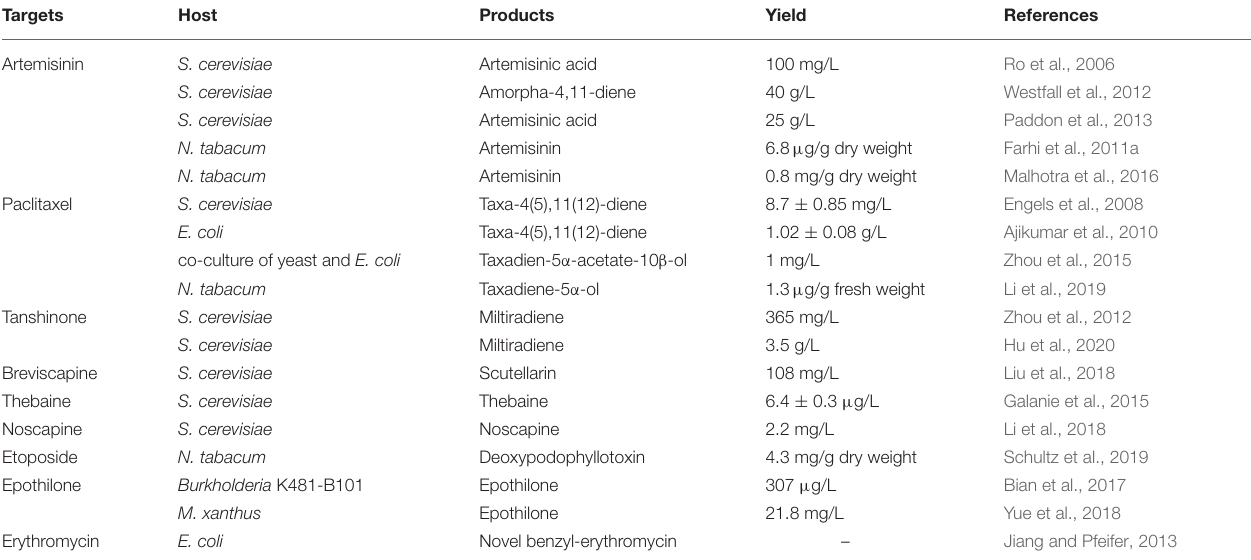
TABLE 1 | Important progresses of selection of examples.